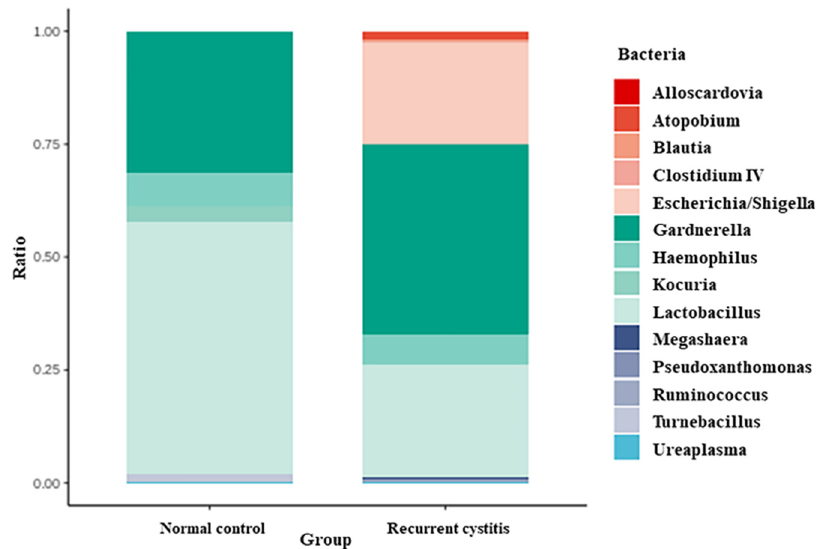
Figure 1. Relative abundance of urinary microbiota in Gardnerella (+) normal control group and Gardnerella (+) recurrent UTI group.